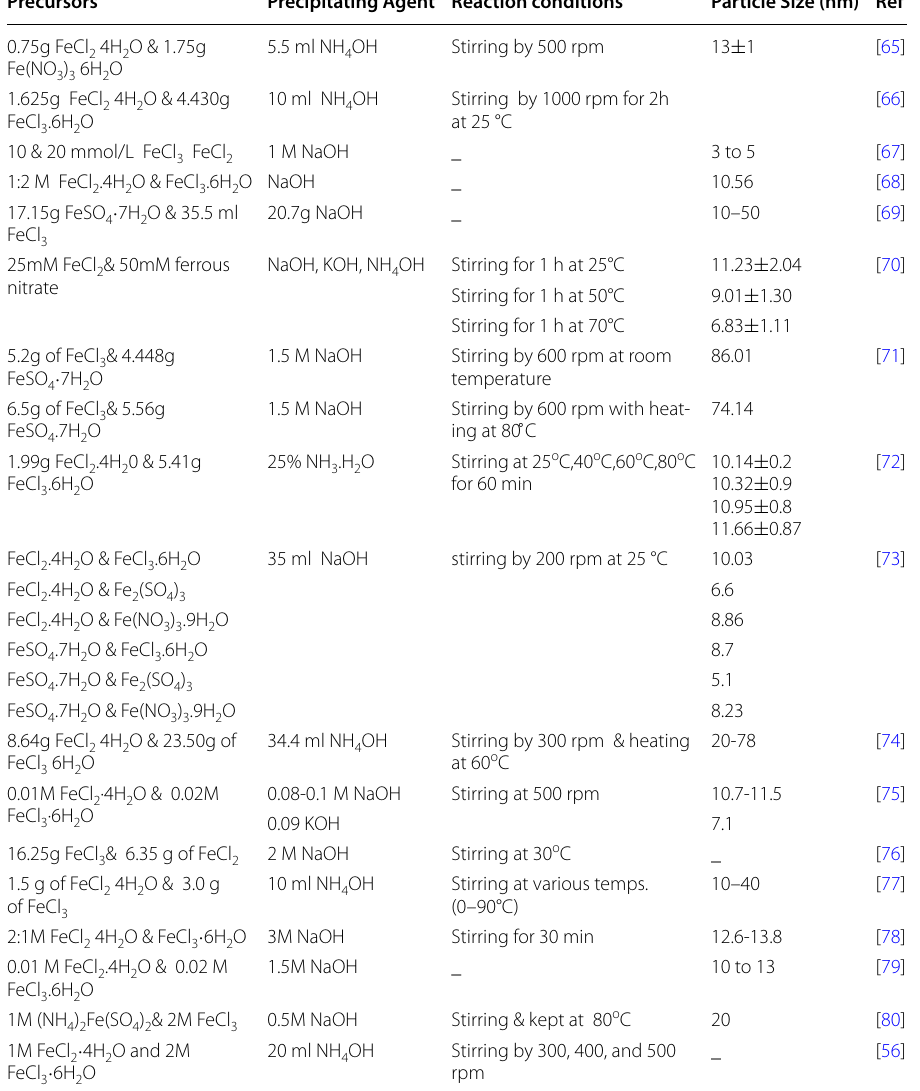
Table 2 Summary of magnetite nanoparticles synthesis by co-precipitation method using mechanical stirrer